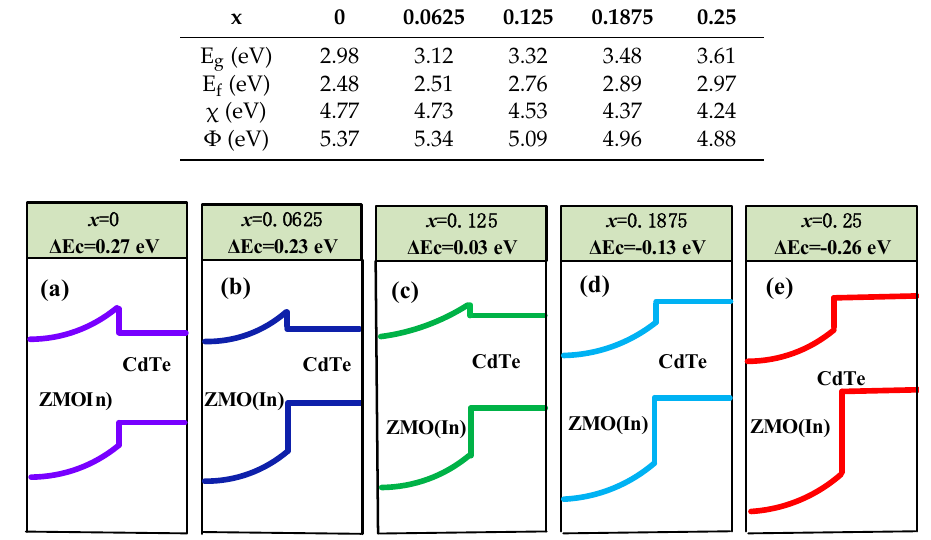
Table 3. The energy band structure parameters of Zn 1 − x Mg x O:In with different Mg concentration x.